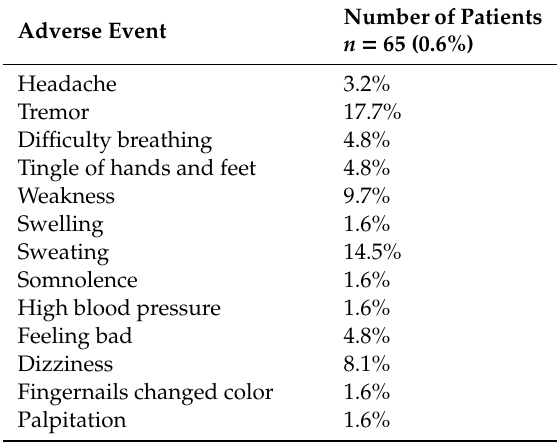
Table 4. Adverse events occurring during a 4-week